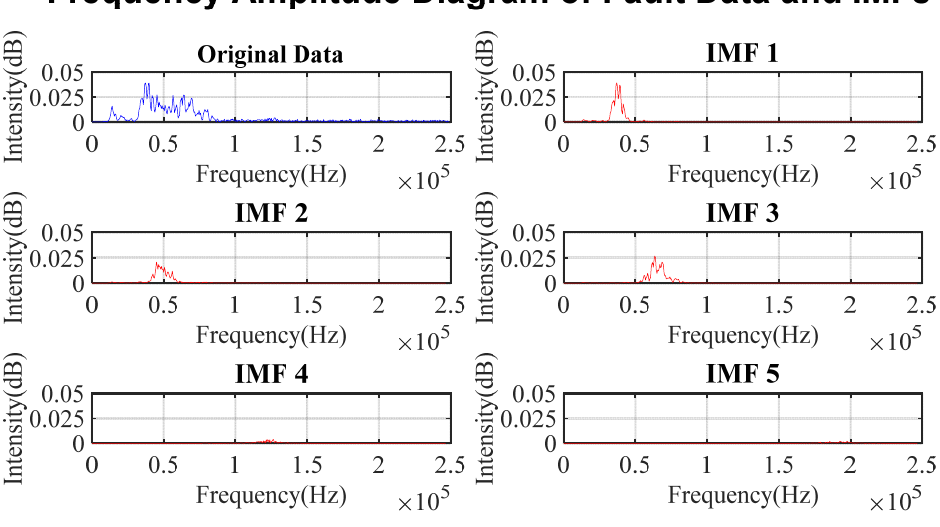
Figure 14. Spectrogram of IMFs when K = 5. Table 2. K = 4, the center frequency of IMFs after VMD of multiple sets of data.